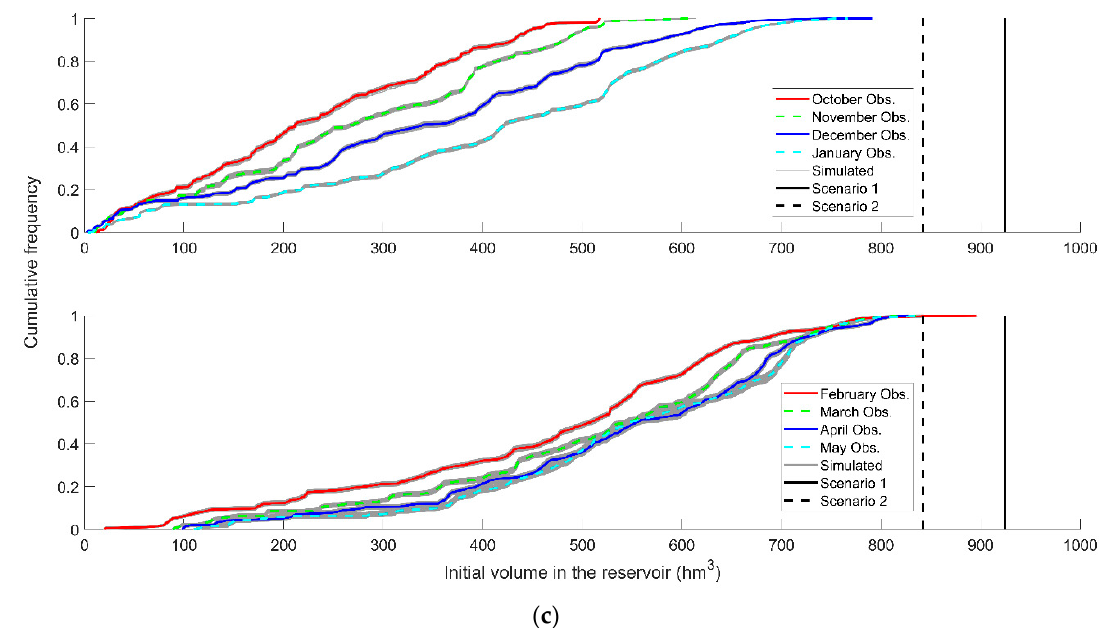
Figure 3. Initial reservoir level assessment. ( a ) Occurrence probability of monthly maximum annual flood. ( b ) Cumulative monthly supply, storage, and supply over storage values. The whole period is represented in grey (1958/1959 to 2012/2013), whereas the selected period is represented in red (1966/1967 to 2012/2013). ( c ) Empirical monthly reservoir level distributions associated with each month in ( a ). Different color lines (red, green, blue, and cyan) represent the observed (Obs.) reservoir level distribution. Grey lines represent the 1000 simulations of monthly initial reservoir levels distributions for Scenario 3. Scenario 1 is represented in a black continuous line, whereas Scenario 2 is represented in a dashed black line.